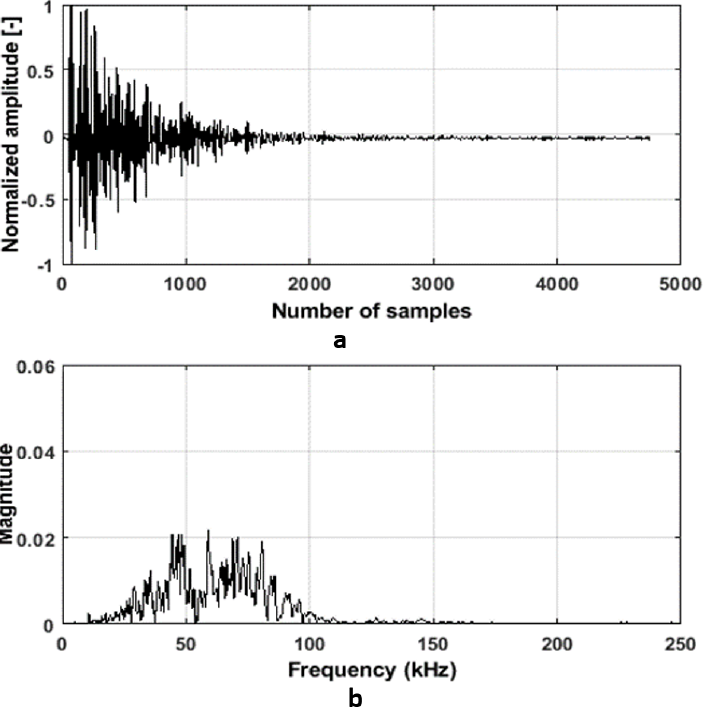
Figure 2. Pre-processed ultrasonic signal: ( a ) in time domain, ( b ) in frequency